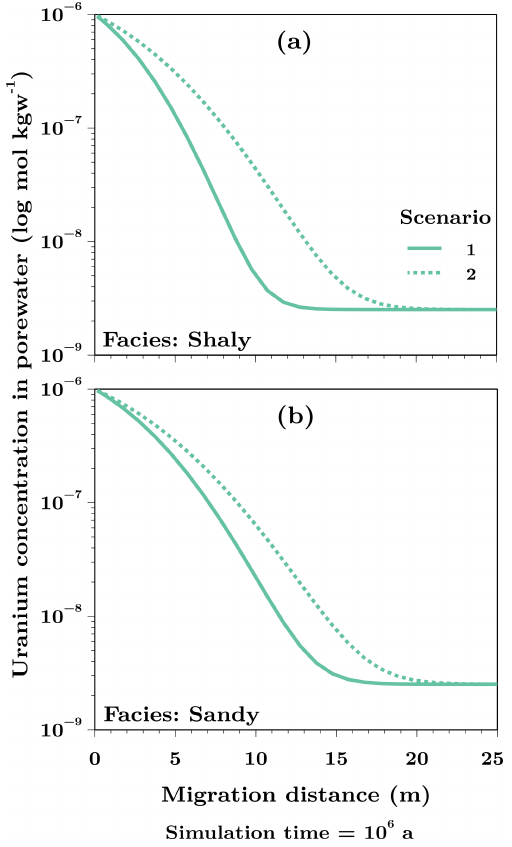
Figure 2. Uranium pore water concentrations in the shaly (a) and sandy facies (b) of the Opalinus Clay after a simulation time of one million years. The solid line shows the results for Scenario 1 using logk = 29 . 22 for the neutral, ternary uranyl complex and the dashed line represents the results for Scenario 2 with logk = 30 .